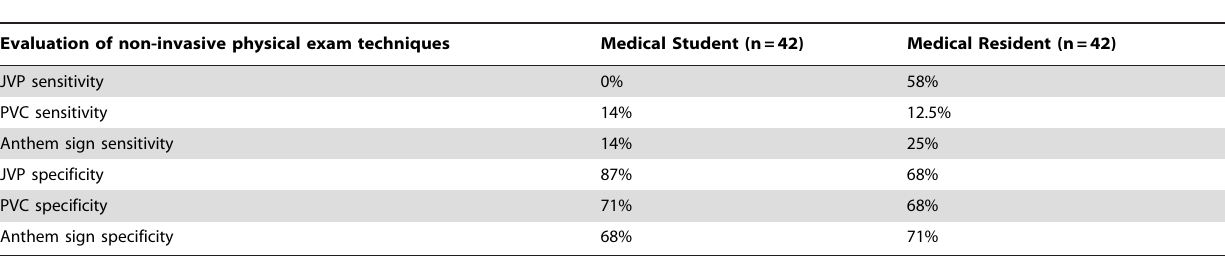
Table 4. Sensitivity and specificity of the physical exam techniques in the 42 co-examined